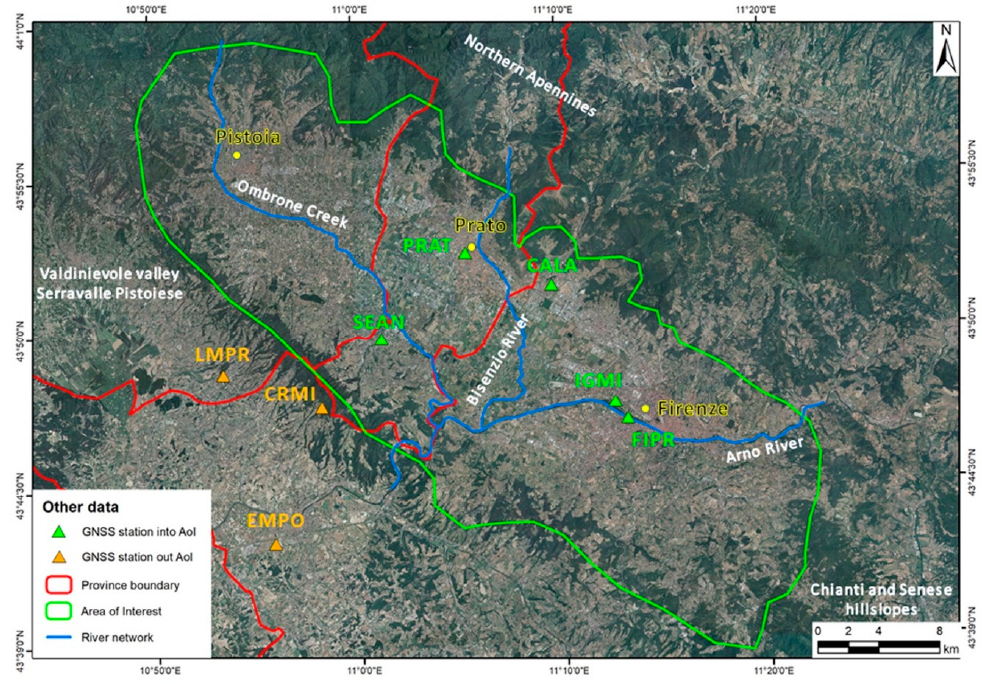
Figure 1. Locations of the Area of Interest (AoI) and the eight GNSS stations used for the geodetic correction: five stations are inside the AoI and three are outside the AoI but close to the FPP plain.